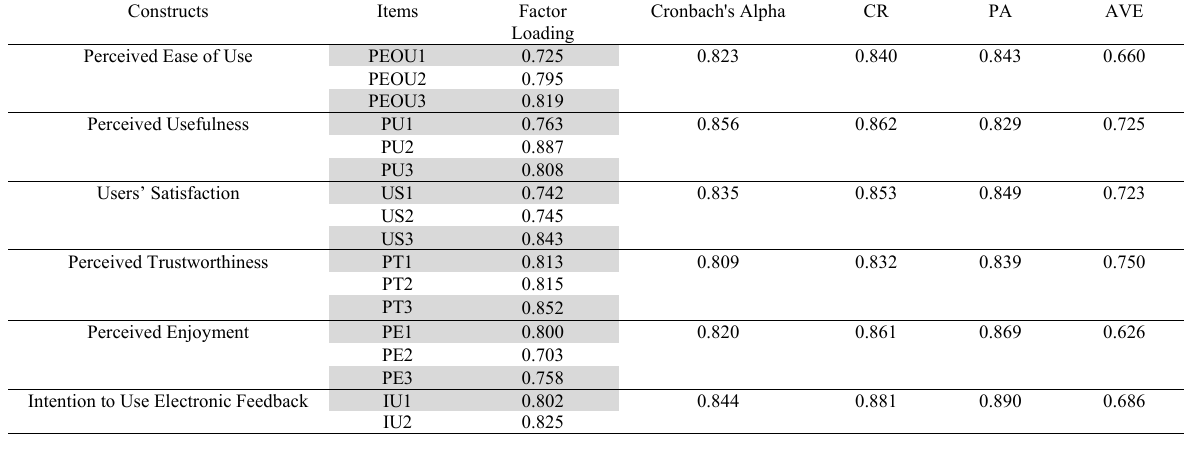
Convergent validity results which assures acceptable values (Factor loading, Cronbach’s Alpha, composite reliability ≥ 0.70 & AVE > 0.5)